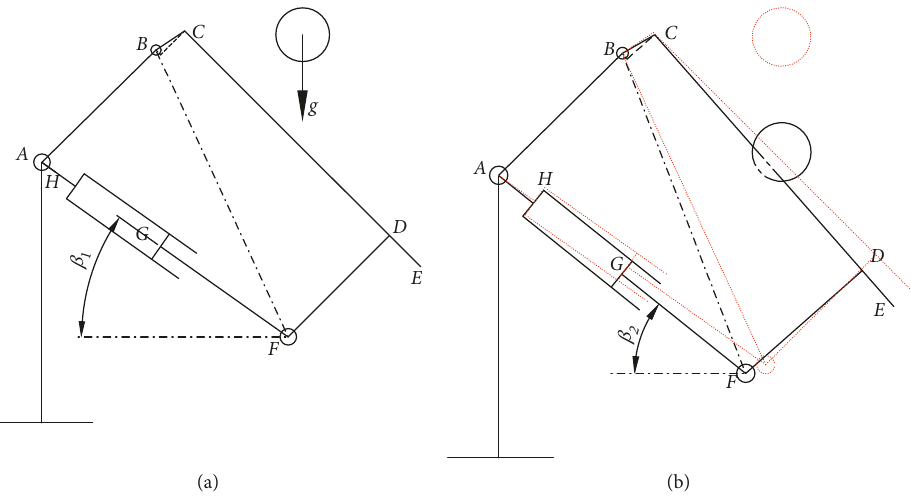
Figure 6: Process of coal gangue particles impacting the tail beam. (a) Before the impact. (b) Critical end state of shock